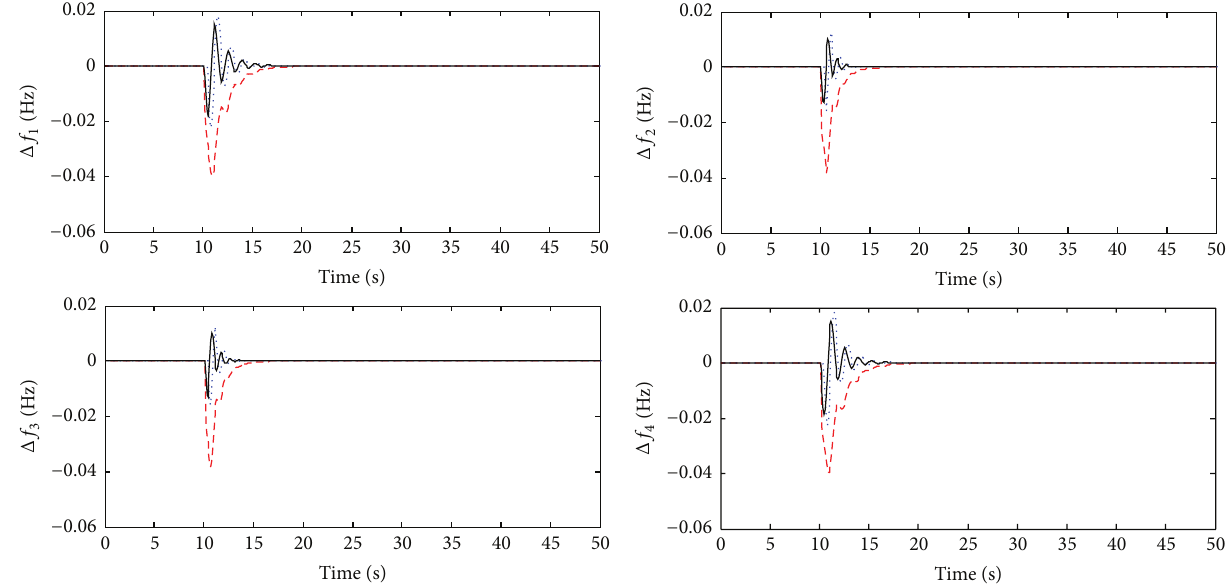
Figure 10: Response of frequency deviation to step load disturbance in Case 1: distributed MPC (solid line), centralized MPC (dotted line), and decentralized MPC (dashed line).